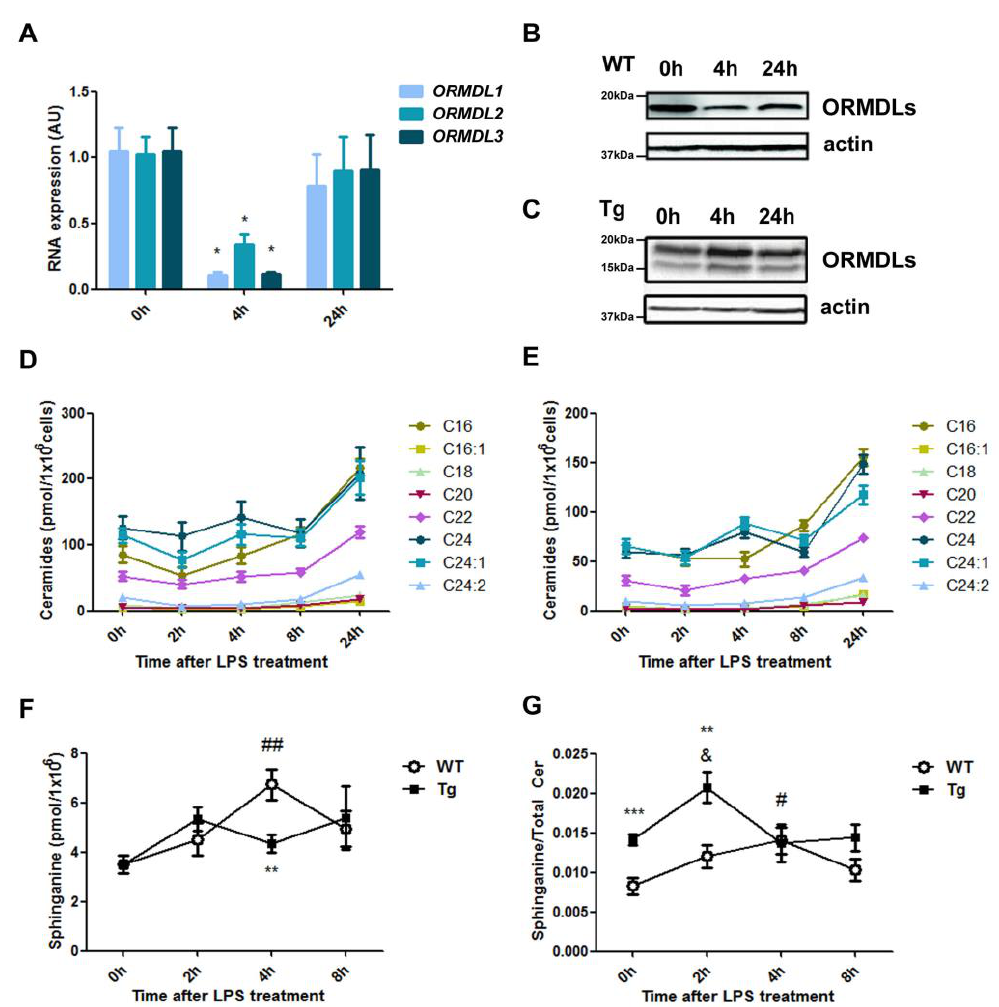
Figure 2. Ceramide production upon lipopolysaccharide (LPS) treatment in BMDM. A – C , Regulation of ORMDLs after activation with 100 ng/mL LPS of BMDM at indicated time points. ( A ) Gene expression analyzed by real-time PCR of ORMDL1, ORMDL2, and ORMDL3. Data are normalized to β -Actin. Statistics: n = 4; Kruskal-Wallis test compared to time 0; * p < 0.05. ( B , C ) Representative Western blot of ORMDL expression in WT ( B ) and Tg mice ( C ) after LPS treatment. ( D , E ) Content of different ceramide species in BMDM macrophages from WT ( D ) and transgenic hORMDL3 Rosa26 ( E ) upon treatment with 100 ng/mL LPS for up to 24 h. ( F , G ) Sphinganine content in LPS-activated macrophages in WT and Tg BMDM. ( F ) Total sphinganine content over time. ( G ) Ratio between sphinganine content and total ceramide over time. Statistics: WT n = 9, Tg n = 7; Bonferroni ANOVA test compared to time 0 of WT BMDM (#) and Tg BMDM (&). t -test between WT and Tg BMDM (*) at different time points; ** p < 0.01; *** p < 0.001; # p < 0.05; ## p < 0.01; & p < 0.05. Error bars represent standard error.